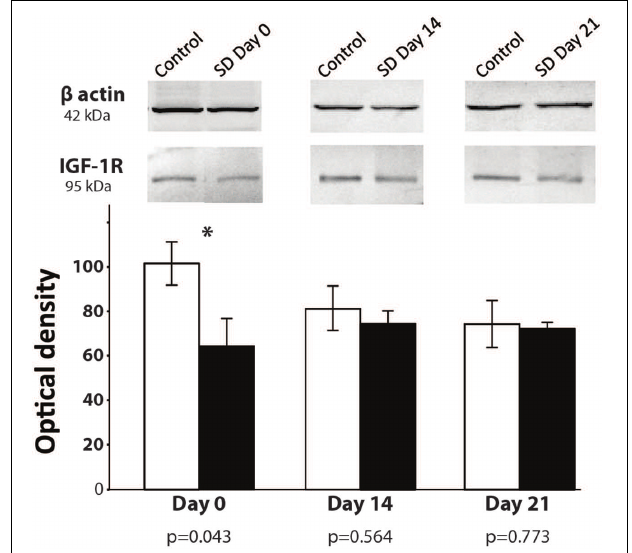
FIGURE 6 | p-IGF-1R expression after 74-h REM SD. Graphics show the mean ± SE of the optical density for p-IGF-1R expression. Asterisks show significant difference. SD = 72-h REM sleep